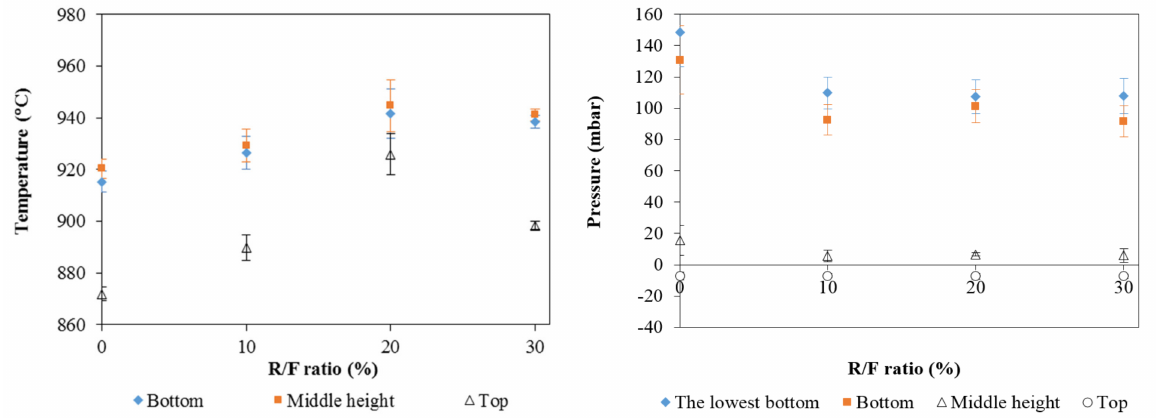
Figure 8. Influence of R/F ratio on the FFB combustor temperature and pressure (gauge pressure) at different heights of the